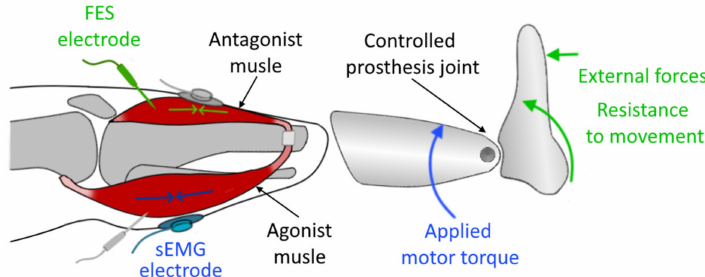
Figure 11. Agonist–antagonist Myoneural Interface (AMI) [153] for leg prosthesis. Volitional contractions of both agonist and antagonist muscles are recorded using an sEMG technique and converted into a control signal for the actuated joint of the prosthesis. The patient can stiffen the joint by simultaneously contracting both muscles of the AMI. The force feedback from the prosthetic joint is provided to the user via artificial contractions of the antagonist muscle, which are triggered by a Functional Electrical Stimulation (FES) generated by the prosthesis controller. These artificially imposed contractions of antagonist muscle create a natural sensation of a load in the volitionally contracted agonist